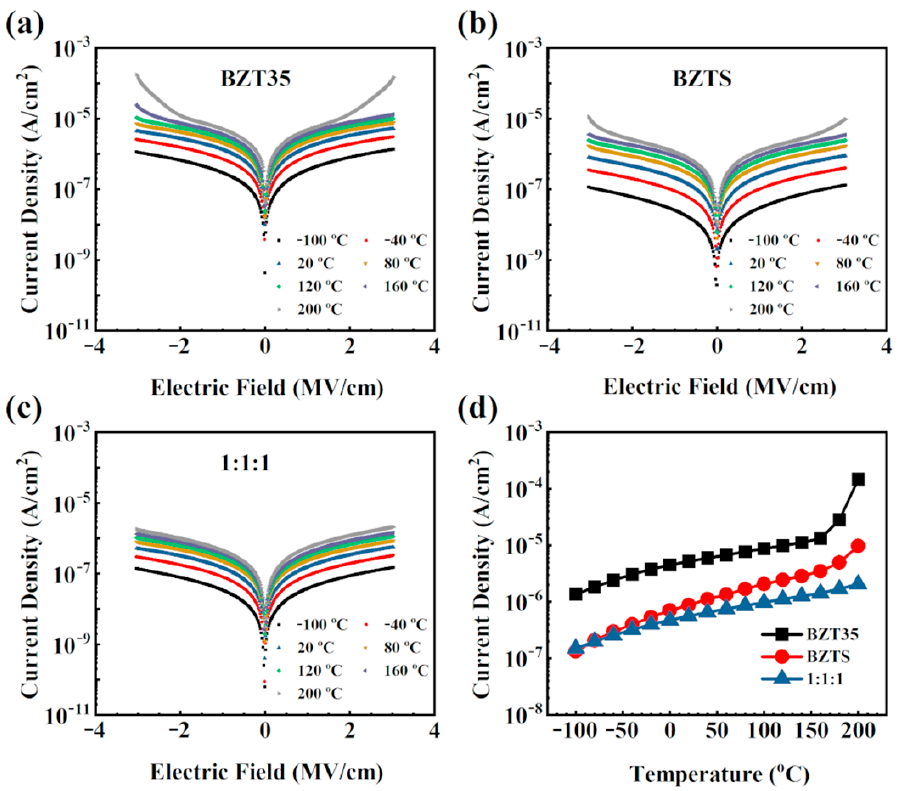
Figure 2. Current density ( J ) vs. electric field ( E ) curves for BZT35 ( a ), BZTS ( b ) and BZT35/BZTS/BZT35(1:1:1) ( c ) films. ( d ) Current density ( J ) at 3.0 MV/cm under different temperature for these three films.